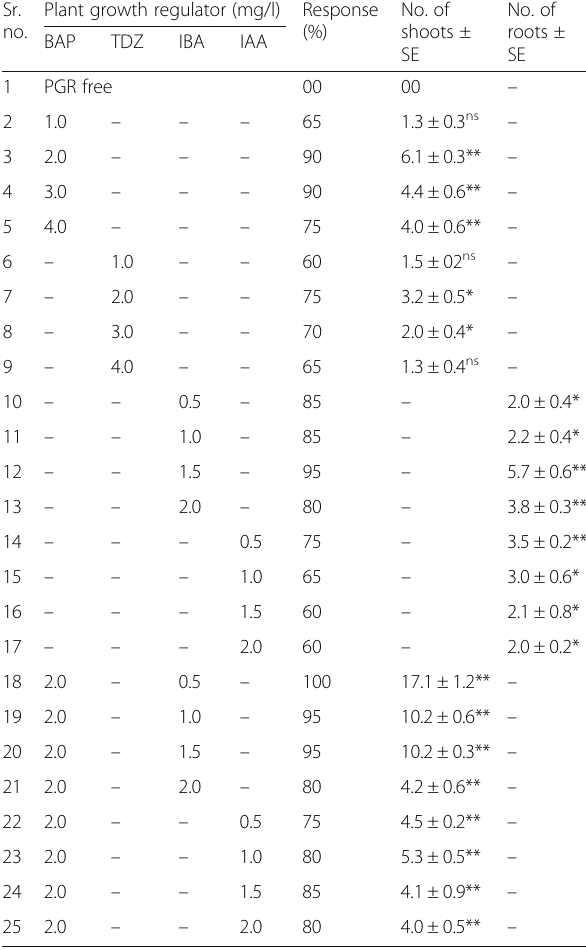
Table 1 Efficiency of different cytokinins and auxins on shoot proliferation and in vitro rooting of C.